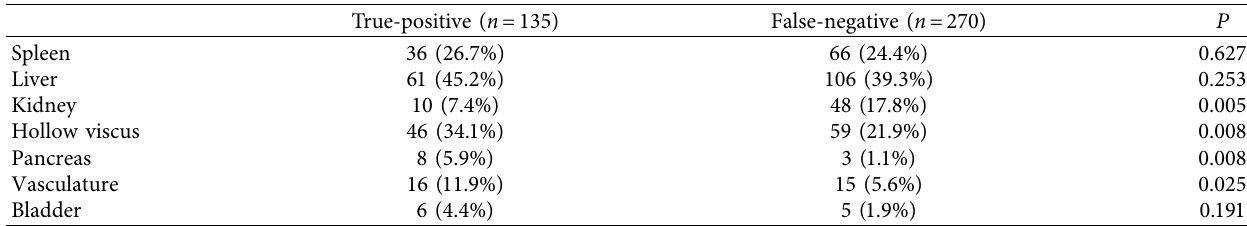
Table 3: Injured organs according to the abbreviated injury scale ≥ 3 in the abdomen.